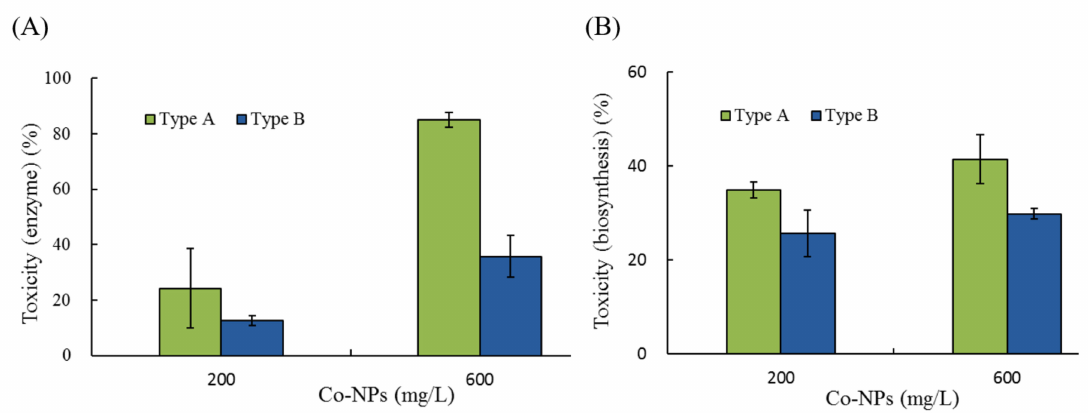
Figure 7. Comparisons of the e ff ects of the two di ff erent sizes of Co-NPs on the enzymatic activity